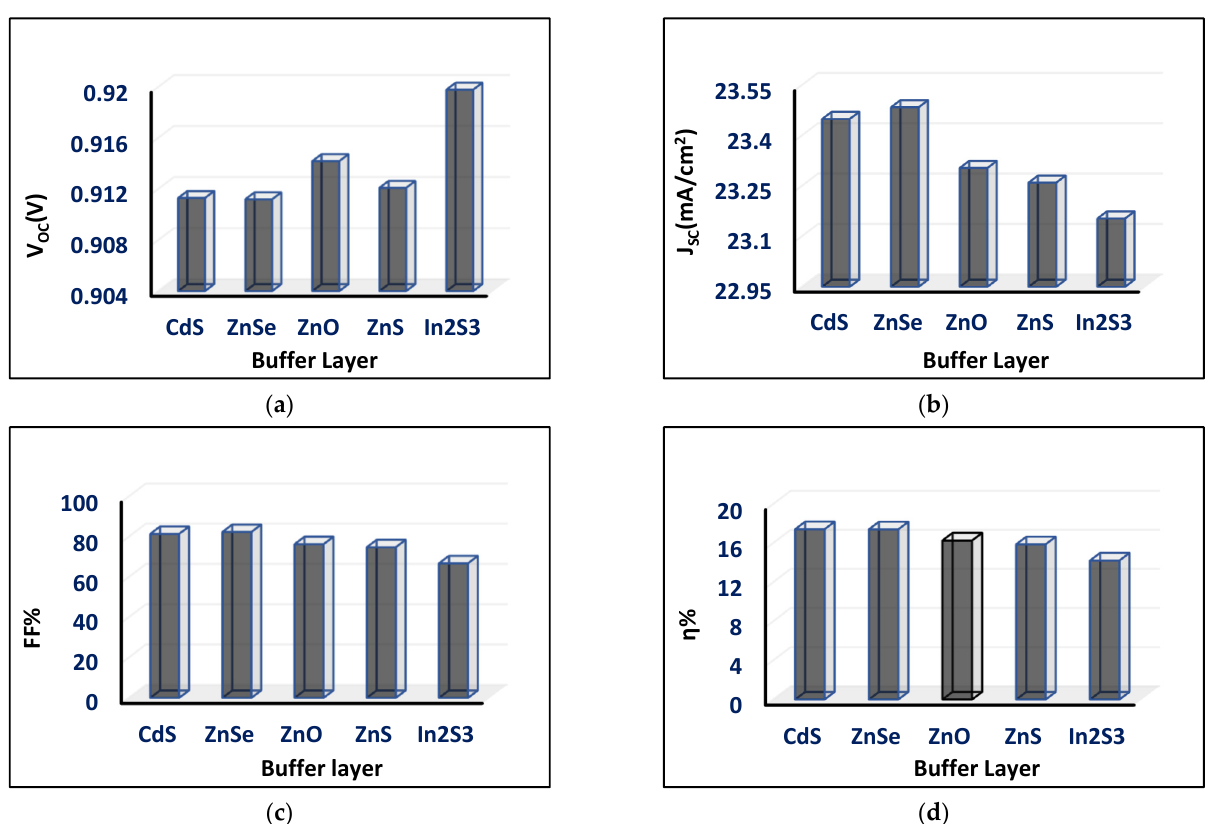
Crystals 2021 , 11 , x FOR PEER REVIEW Figure 2. Effectiveness of the buffer material (donor) layer on photovoltaic parameters ( a ) V OC ( b ) J SC ( c ) FF ( d ) η . Table 4. Effectiveness of the buffer material (donor) on J–V characteristics.